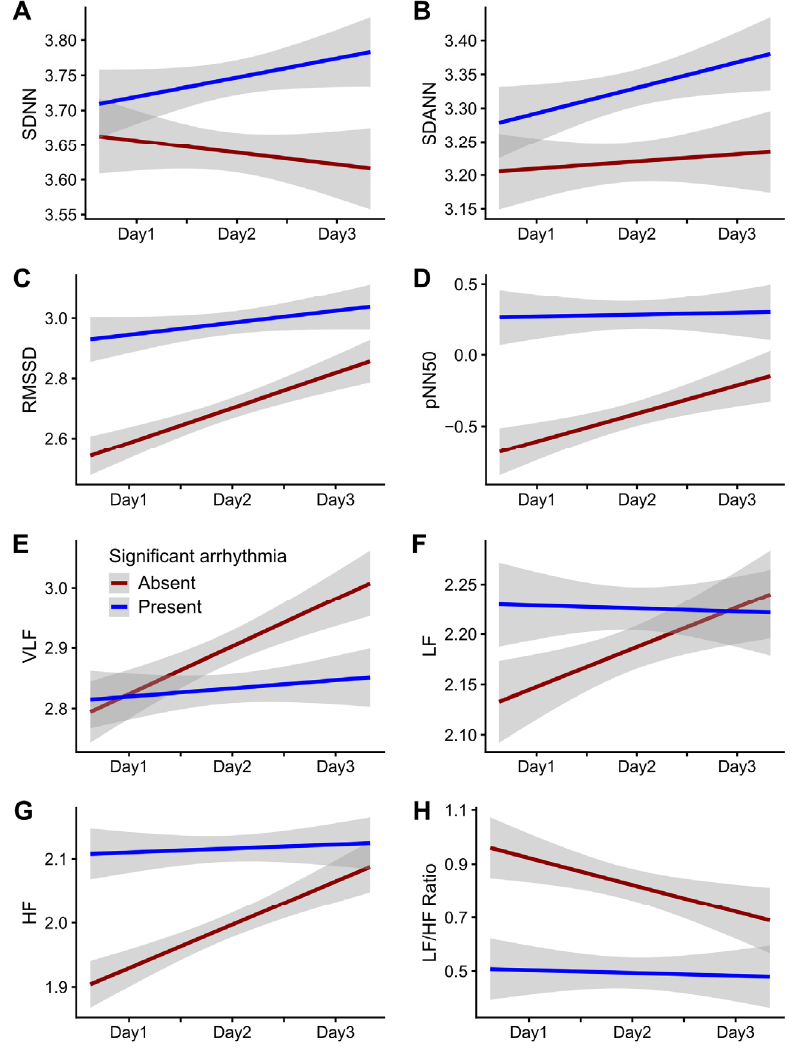
Figure 4. Temporal changes in HRV parameters according to significant arrhythmia. The heart rate variability (HRV) parameters included time-domain parameters such as SDNN ( A ), SDANN ( B ), RMSSD ( C ), and pNN50 ( D ), and frequency-domain parameters such as VLF ( E ), LF ( F ), HF ( G ), and the LF/HF ratio ( H ). Linear regression lines and 95% confidence intervals are presented. SDNN, SDANN, RMSSD, pNN50, and LF/HF ratio values were natural log-transformed, and the VLF, LF, and HF values were square root-transformed. SA, significant arrhythmia; SE, standard error; SDNN, standard deviation (SD) of normal-to-normal intervals during an hour; SDANN, SD of the averages of the NN intervals in all five-minute segments during an hour; RMSSD, square root of the mean square of the differences between adjacent NN intervals; pNN50, percentage of the number of pairs of adjacent NN R-R intervals differing by >50 ms in the total NN intervals; VLF, very-low-frequency (0.003–0.04 Hz) power; LF, low-frequency (0.04–0.15 Hz) power; HF, high-frequency (0.15–0.40 Hz) power.